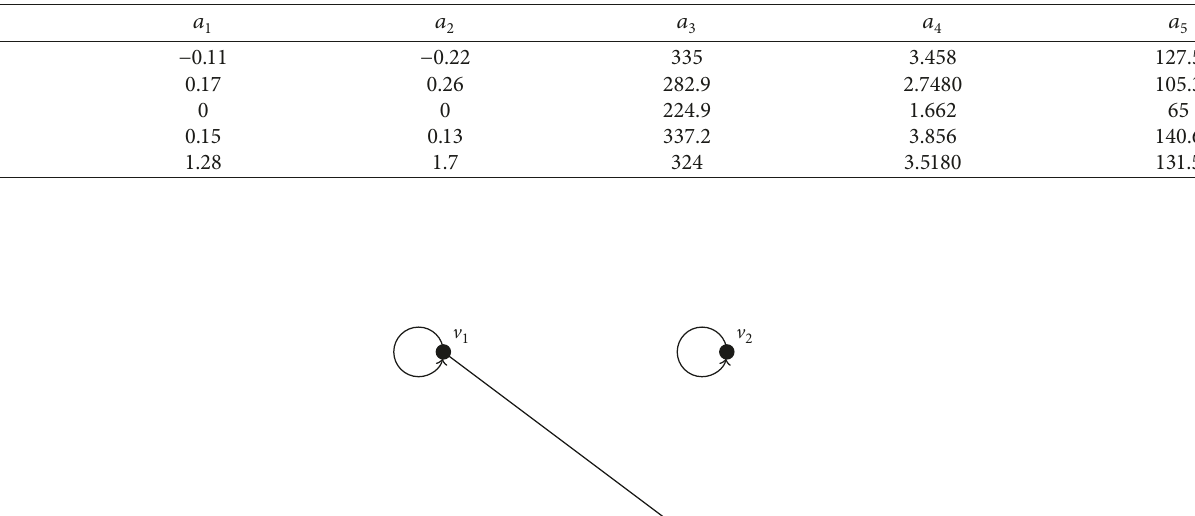
Table 5: Quantitative attributes of five amino acids.